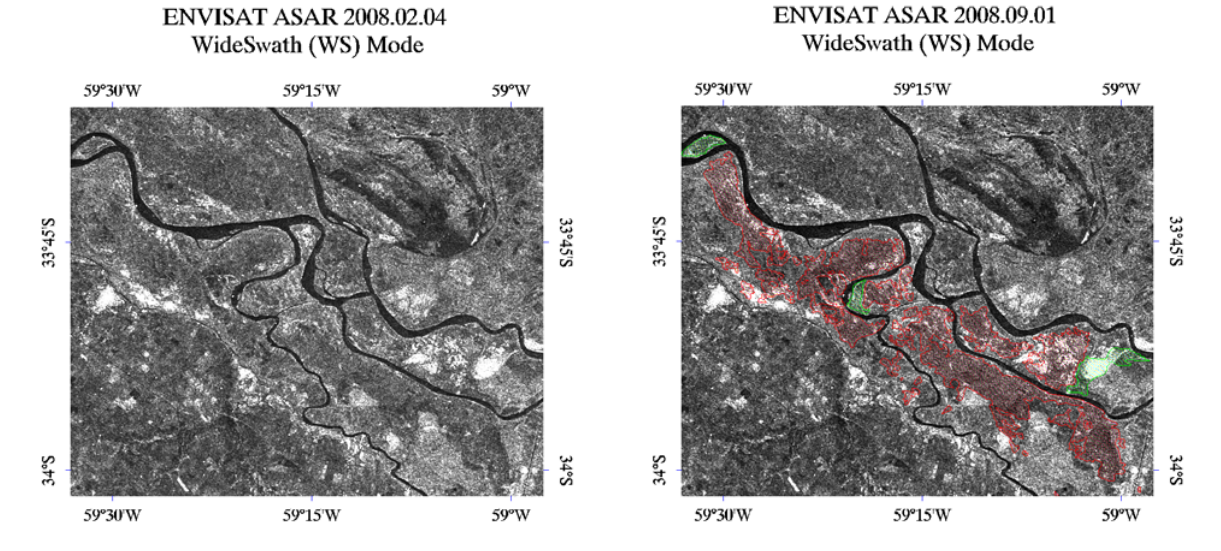
Figure 2. Envisat ASAR Wide Swath image of the Paraná River Delta prior to the fire events (2008.02.04, left) and after them (2008.09.01, right). Burned junco marsh areas are shown in red, while selected not burned areas are shown in